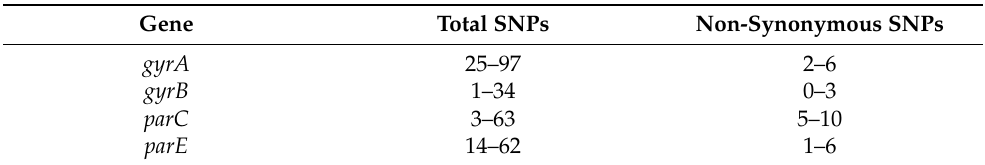
Table 1. A summary of the ranges of SNP frequencies observed across the topoisomerase genes of each of the 72 isolates analyzed.